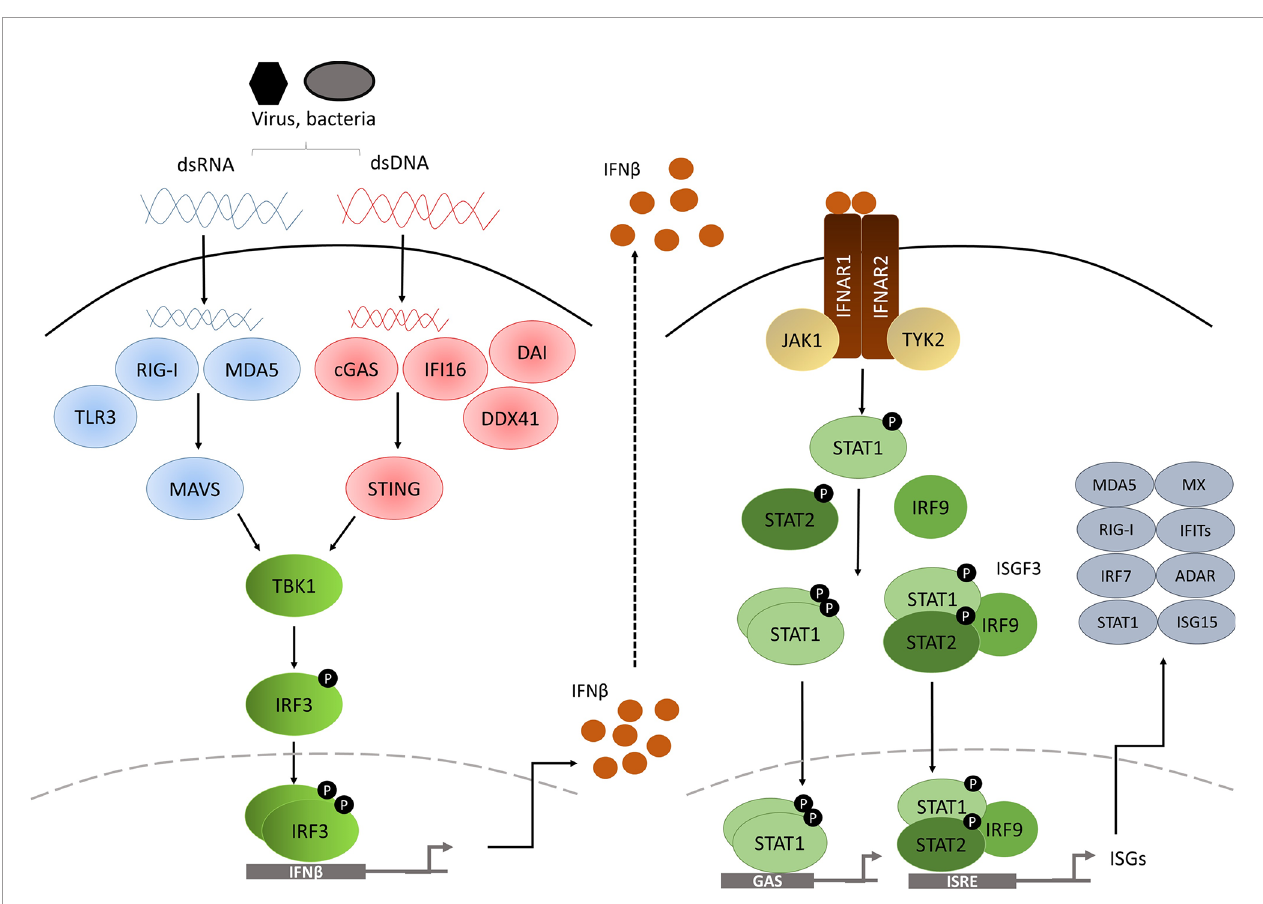
FIGURE 1 | Diagram of the type I IFN pathway [modi fi ed from